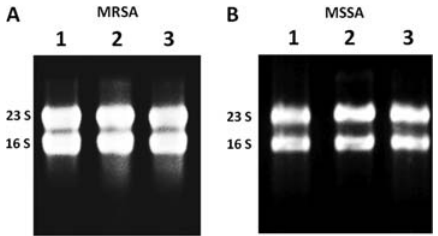
Figure 3. Gel electrophoresis of total RNA that was obtained from sessile cells with sheared whole-cell lysis coupled to the RNeasy Mini Kit. Lanes 1 , 2 , and 3 represent three independent experiments using the methicillin-resistant S. aureus (MRSA) isolate BMB9393 ( A ) and the methicillin-susceptible S. aureus (MSSA) isolate HC474 ( B ).